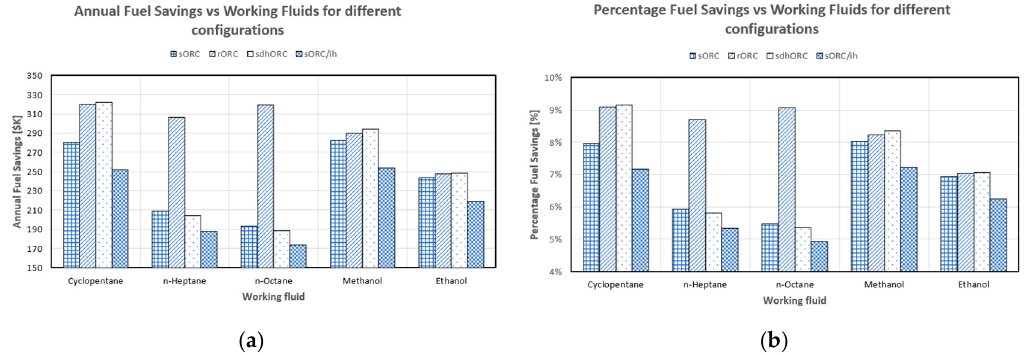
Figure 8. Annual Fuel Savings for different working fluids and cycle configurations ( a ) In Thousand dollars ($) ( b ) Percentage fuel savings.